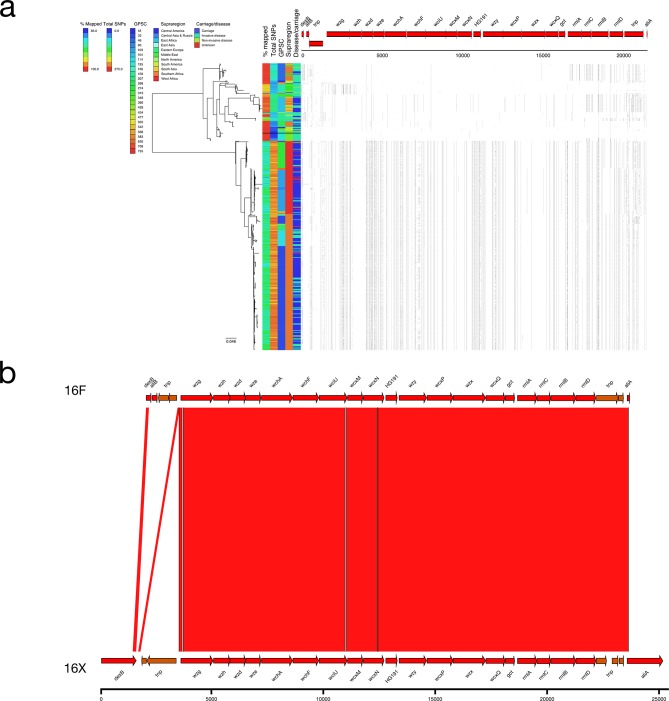
(a) Phylogeny and SNP map of serotype 16F. (b) Comparison of the putative serotype 16X sequence and the serotype 16F reference sequence.